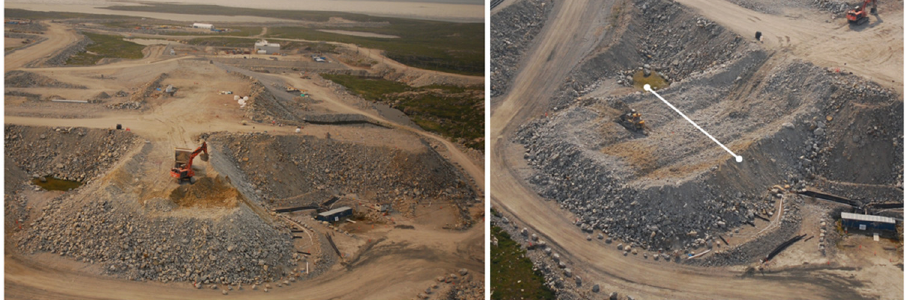
Figure 1. Overview of test piles area during initial stages of the Type I test pile deconstruction ( left ) and the Type I test pile at excavation of bench three with two sampling trenches ( right ). The white line on the right photo shows the approximate location of the 15 m profile. Photographs courtesy of Sean Sinclair.